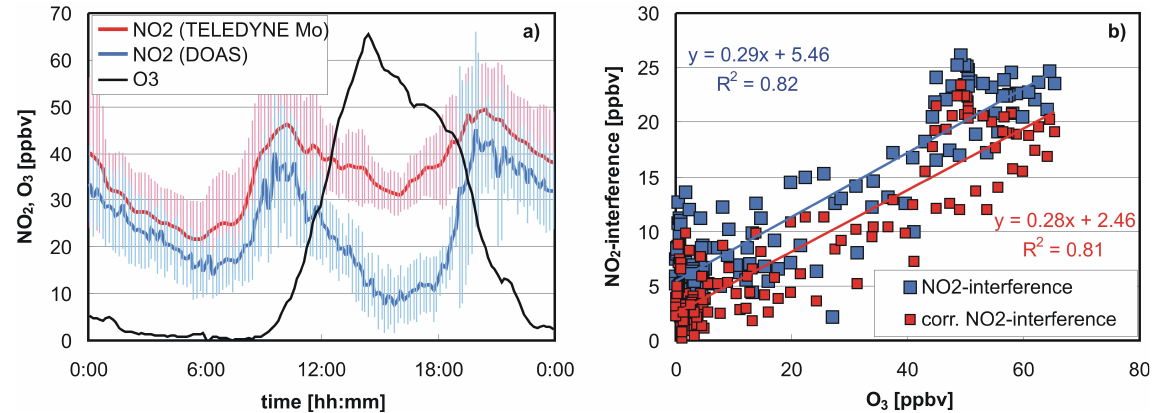
Fig. 1. (a) Campaign averaged NO and O diurnal profiles in Santiago de Chile, 2005 (Elshorbany et al., 2009). The error bars show 2 3 the 1 σ error of the average of all 10min NO data. The spectroscopic DOAS technique was used as a reference in this campaign. (b) 2 Correlation of the NO -interference of the chemiluminescence instrument (i.e. difference NO 2 ozone concentration. In addition, the NO -interference, which was corrected for the HONO and PAN interferences of the chemiluminescence 2 instrument, is also shown (“corr. NO 2